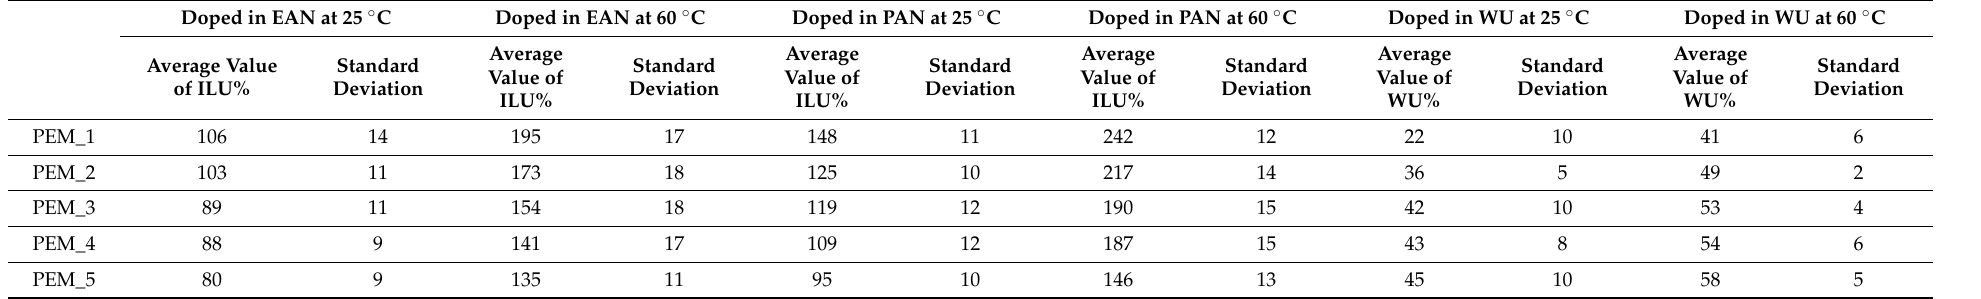
Table 3. Uptake values of PEM_1–PEM_5 membranes.